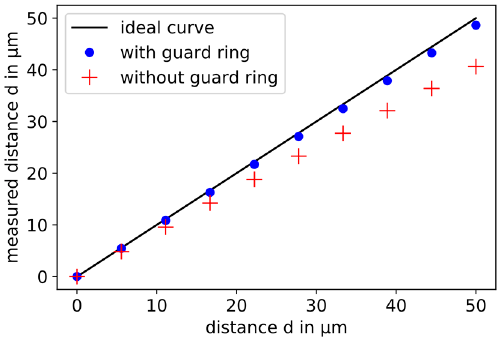
Figure 6. Comparison of the FEM simulation results of capacitive displacement sensors with (blue dots) and without (red crosses) guard rings with the ideal curve (black line). The slope error is reduced by using a guard ring.